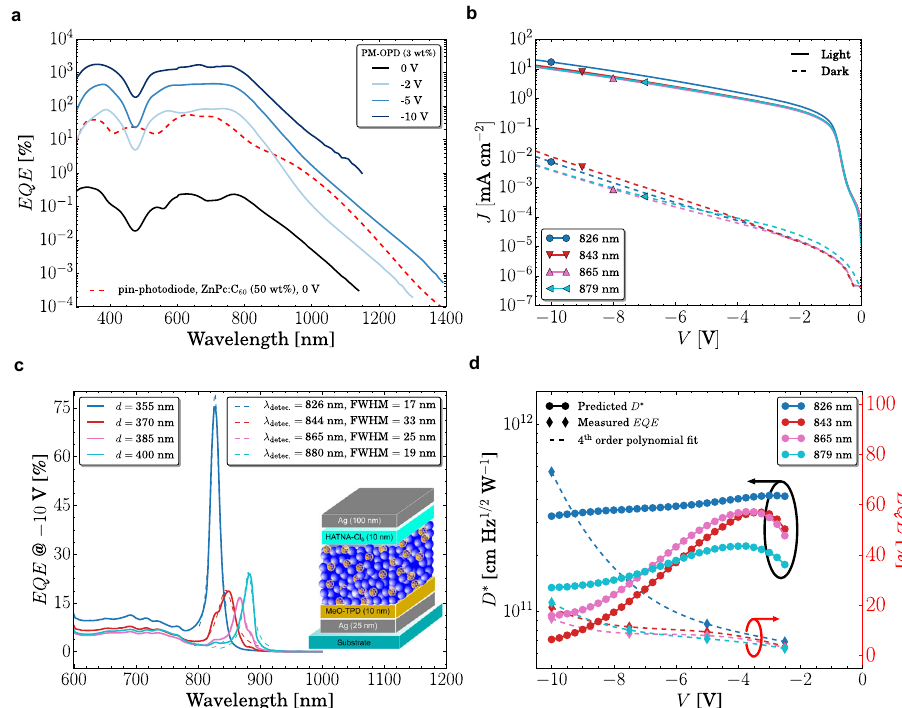
Fig. 4 Photomultiplication in the CT region and used in narrowband devices. a EQE as a function of excitation wavelength for the broadband photodetector. Red dashed line shows the EQE spectrum of a conventional ZnPc:C 60 (50 wt%) photodiode and the black solid line the PM-OPD, both at 0 V. Solid lines show the spectra of the PM-OPD (3 wt% C 60 ) under bias as indicated in the legend. Under − 5 V, the higher injection provided by the energy level bending leads to an EQE higher that of a conventional pin-photodiode. b JV characteristics under dark and under 100 mW cm − 2 of four different narrowband devices with varying resonant wavelength as indicated in the legend. c EQE of cavities of the same devices shown in b at − 10 V. As the active layer thickness increases from 355 to 400nm, the resonant wavelength redshifts from around 830 to 880 nm. Dashed lines show the fi t to a Lorentzian function, from which the FWHM is extracted. d EQE measured at different voltages is fi tted with polynomial function, from which D * is predicted. An optimum operation region is found around − 3.5 V, where D * of 6 × 10 11 Jones is